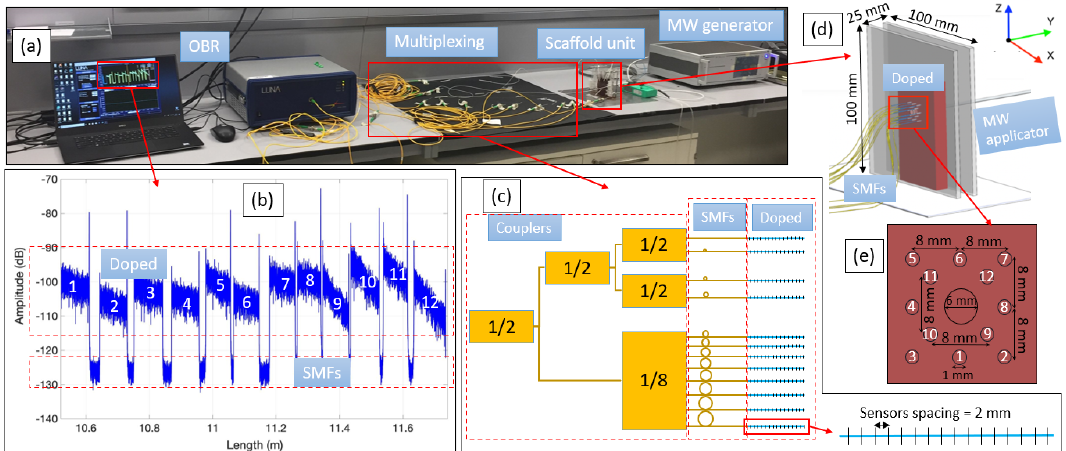
Figure 1. The experimental setup ( a ) consists of a Luna OBR interrogator with data acquisition software; Multiplexing setup for twelve high-scattering MgO nanoparticle-doped fibers spliced with single-mode fibers (SMFs) and connected through couplers ( b , c ); Scaffold ( d ) with a liver phantom and holes for holding an microwave (MW) applicator and twelve sensing fibers ( e ); MW generator to produce MW